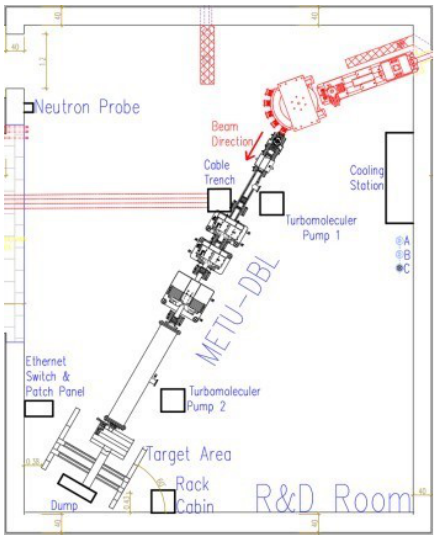
Fig. 2. A 2D drawing of METU-DBL and the R&D room. A 5- port switching magnet is shown in red color at the beginning point of METU-DBL. The length of the beamline is approximately 7.5 m starting from the 5-port switching magnet.